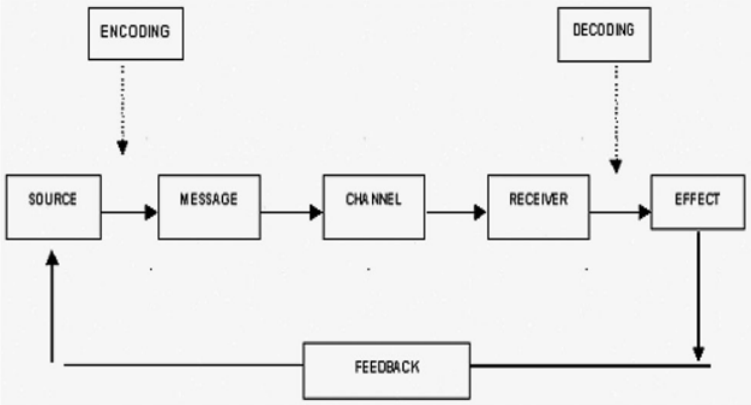
Fig. 2. Source-Message-Channel-Receive-Effect Model by Rogers & Shoemaker